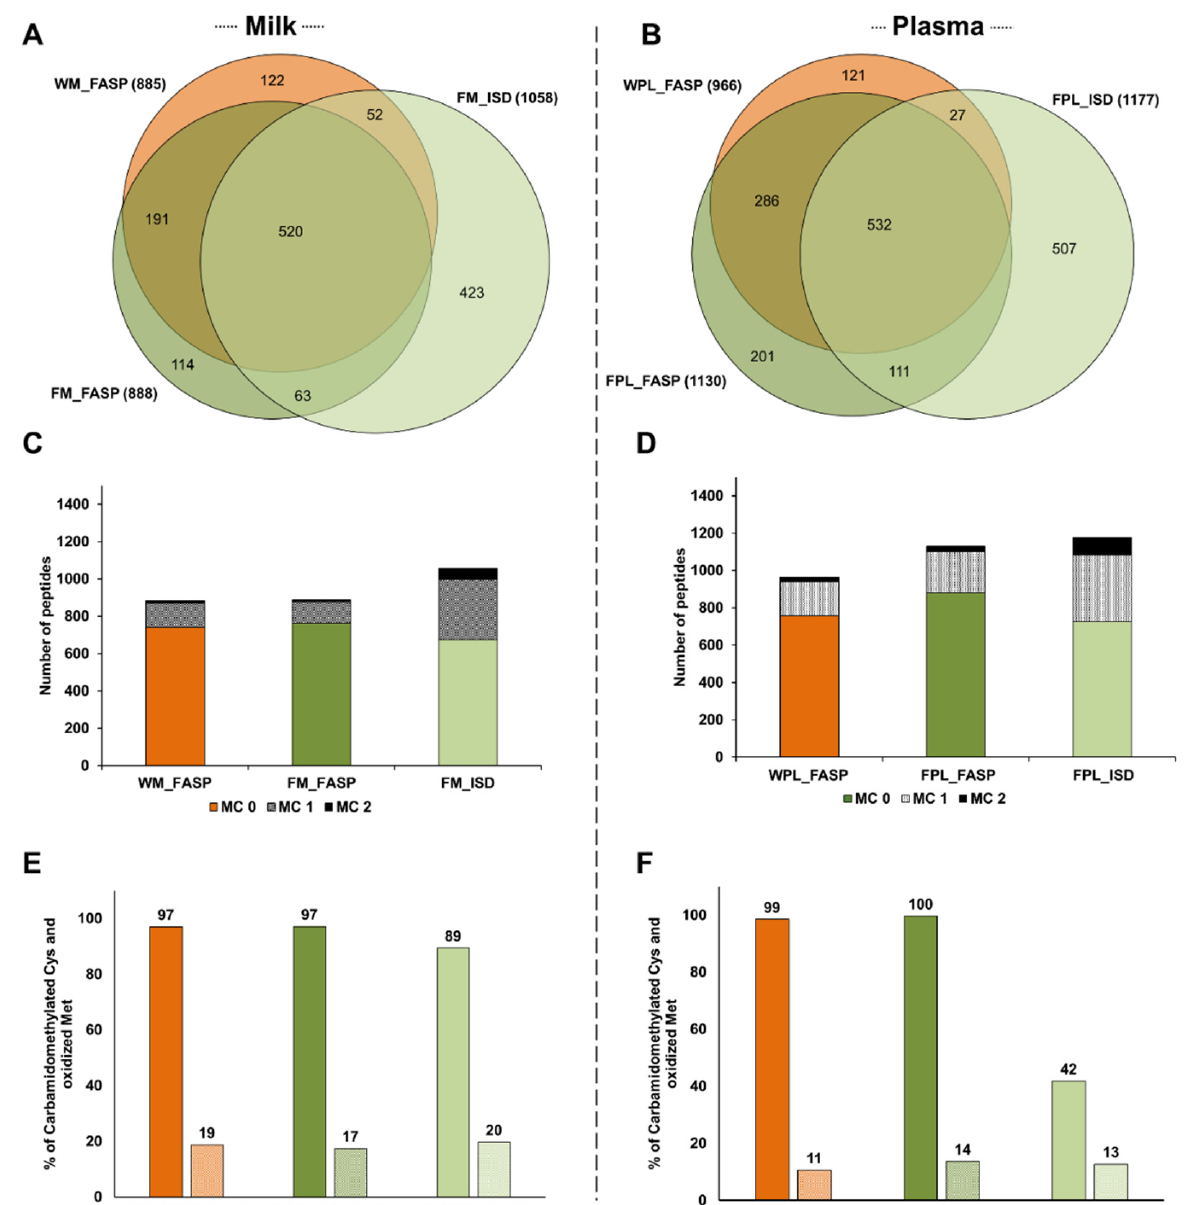
Figure 3. Quantitative Venn diagrams for the number of peptides identified in ( A ) human milk (M) and ( B ) plasma (PL) after digesting a diluted aliquot of the whole sample (W) by FASP as well as protein extracts (F) by FASP and in-solution digestion (ISD). The numbers of peptides with up to two missed cleavages (MC) identified in ( C ) human milk and ( D ) plasma. Efficiency of carbamidomethylation and methionine oxidation as % observed for cysteine/methionine containing sequences in ( E ) human milk and ( F ) plasma. Experiments were performed in three independent replicates. Identifications are presented as total numbers of unique peptides for each procedure.